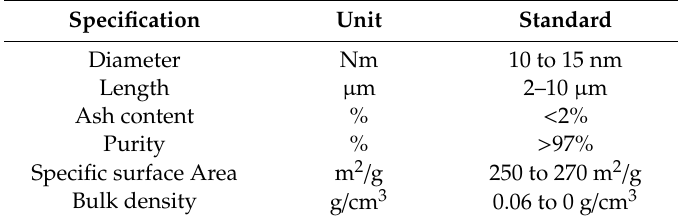
Table 2. List of Specification related to Multi-walled Carbon Nanotube